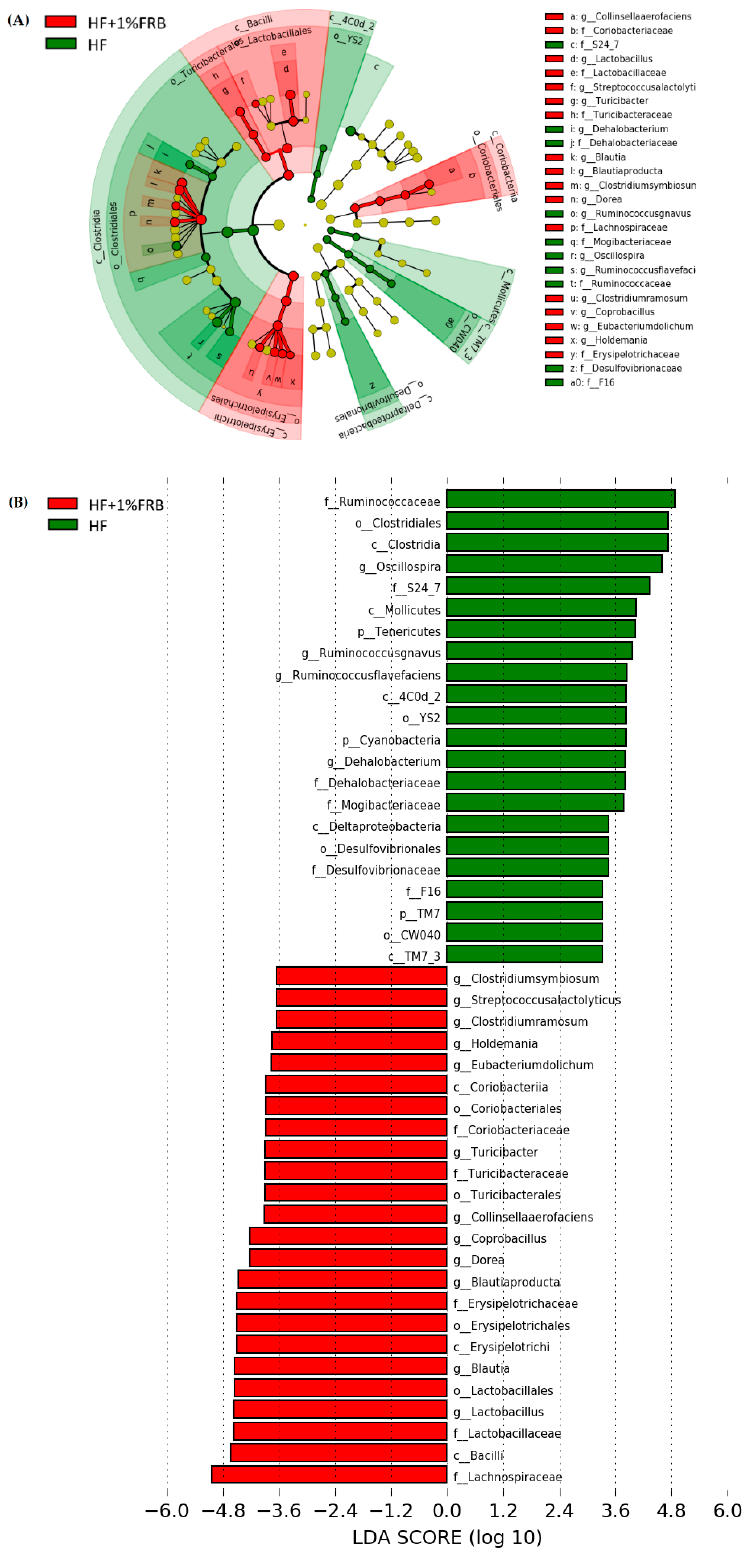
Figure 13. Effects of the water extract of fermented rice bran (FRB) on taxonomies of fecal microbiotic compositions in aged rats with high-fat (HF) diet feeding. ( A ) A linear discriminant analysis of the effect size (LEfSe) of the most significant abundance differences in the fecal microbiota in the HF and HF + 1% FRB groups ( n = 5). ( B ) Bacteria meeting the LDA threshold ( ≥ 2) differed in the HF and HF + 1% FRB groups ( n = 5).